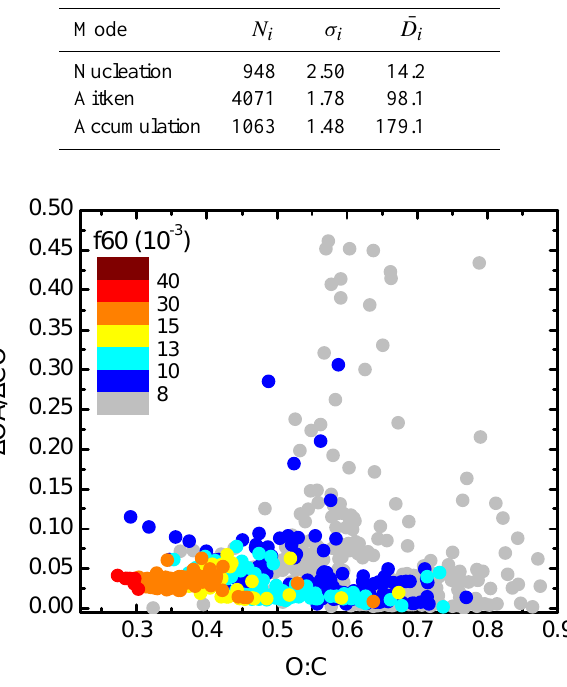
Figure 8. (cid:49) OA /(cid:49) CO mass ratios vs. O : C ratio.